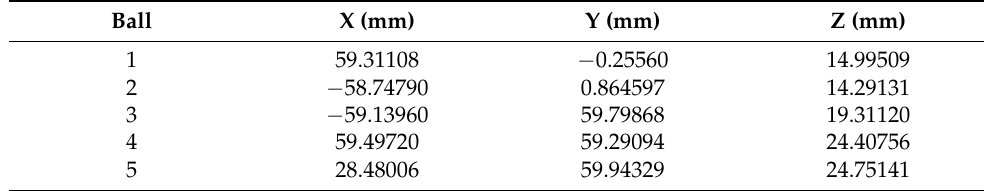
Table 1. Centre positions of the